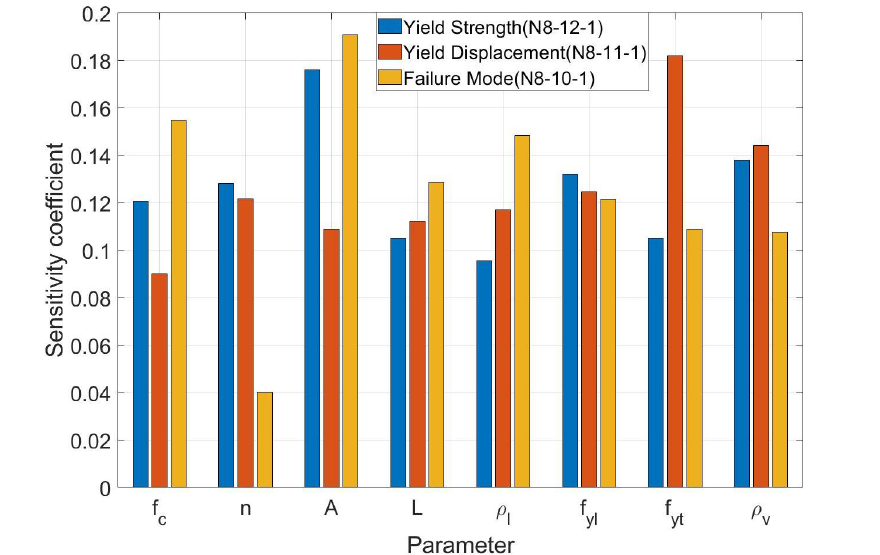
Figure 13. Sensitivity Coefficient of